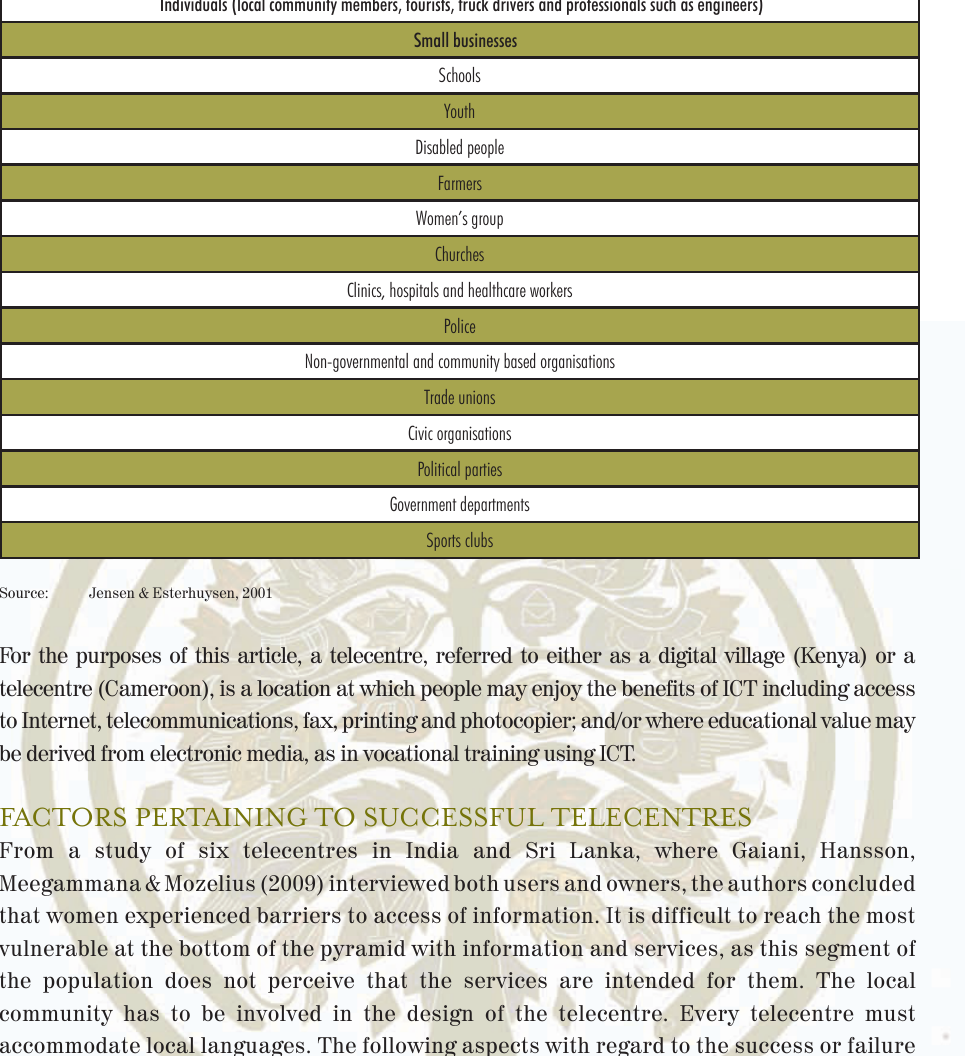
TARGET GROUPS FOR TELECENTRES Individuals (local community members, tourists, truck drivers and professionals such as